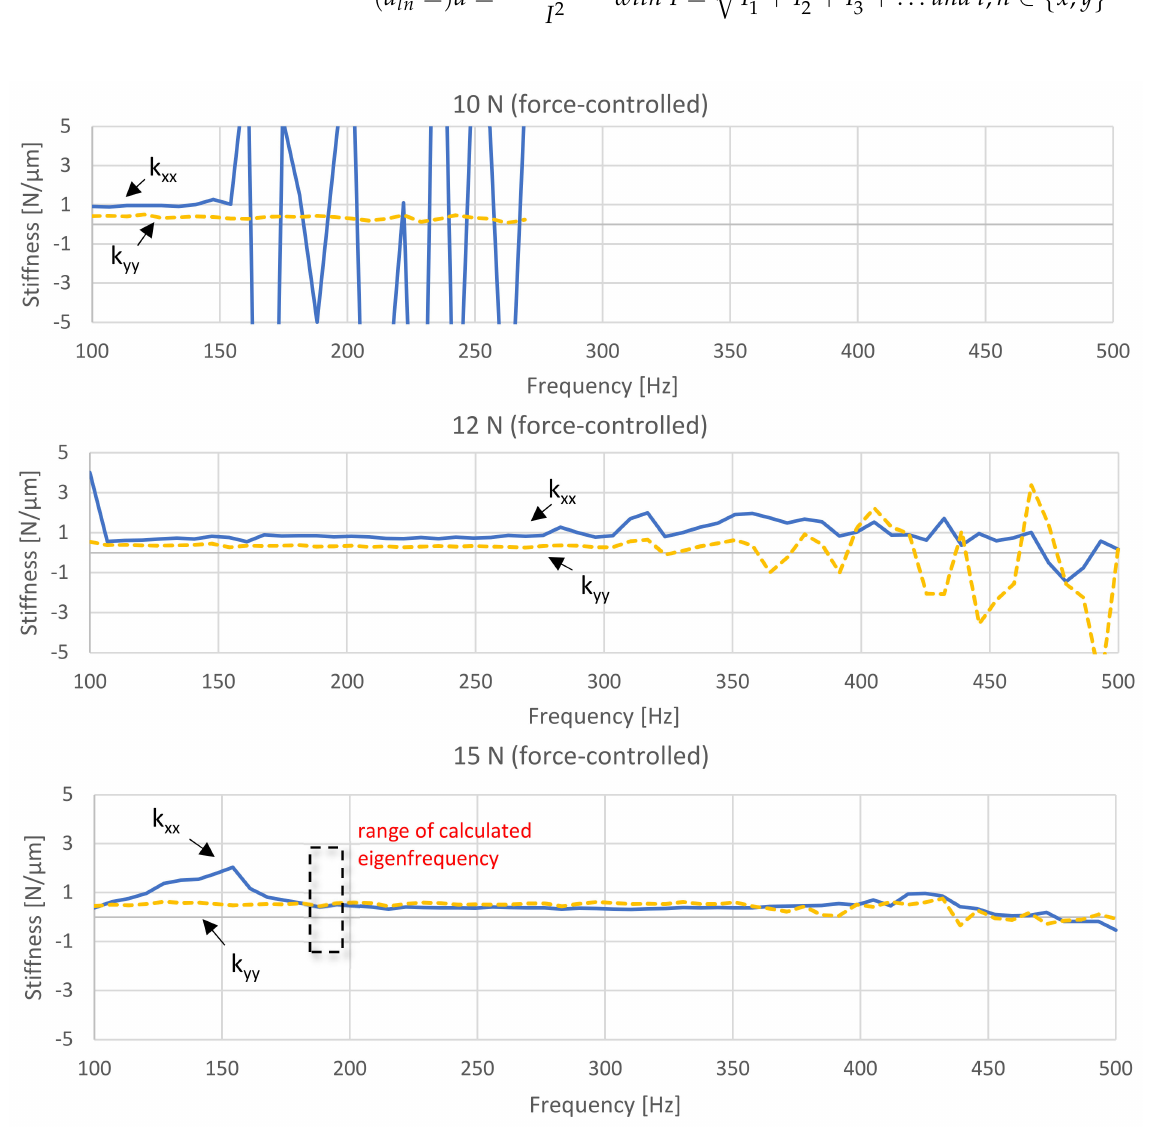
Figure 7. Force-controlled pre-tests: 10 N ( top ), 12 N ( center ), 15 N ( bottom ). In case of sinusoidal (harmonic) curves, the root-mean-square I (index is equal to order of super harmonics) depends linearly on the amplitude ˆ i [24]; this also counts for the amplitudes r in the sensor signal parameters ˆ F , ˆ u b , ˆ w b − t